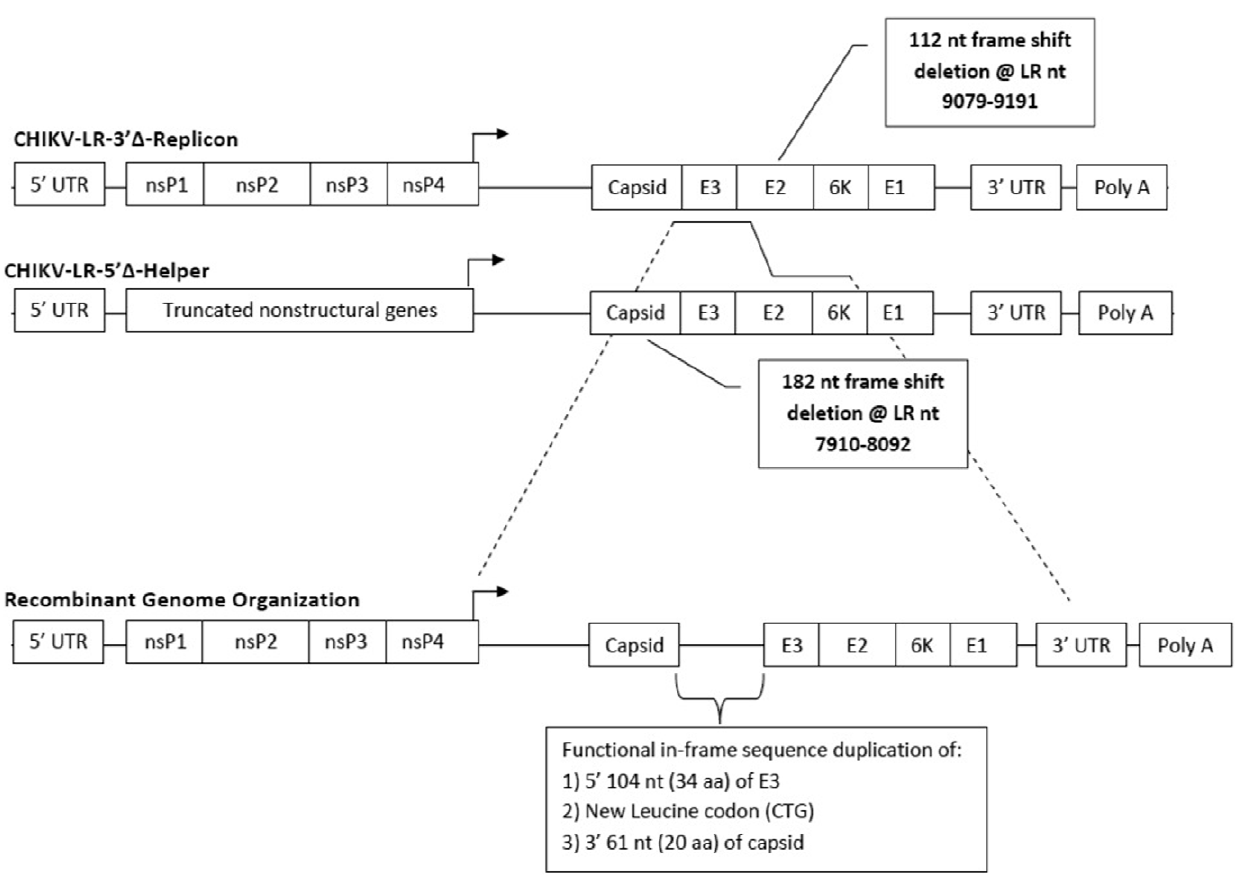
Figure 3. Schematic representation of parental replicon/defective helper recombinant cross (CHIK-LR-3 9 D -Replicon and CHIK-LR- 5 D 9 -Helper) along with sequence topology analysis of the cross-over region and resulting recombinant topology of clonally isolated recombinant genomes. Genes not necessarily shown to scale. aa-amino acid, E-envelope glycoprotein, ns-nonstructural, nt-nucleotide, LR-LaReunion, and UTR-untranslated region, @LR location of sequence deletion.